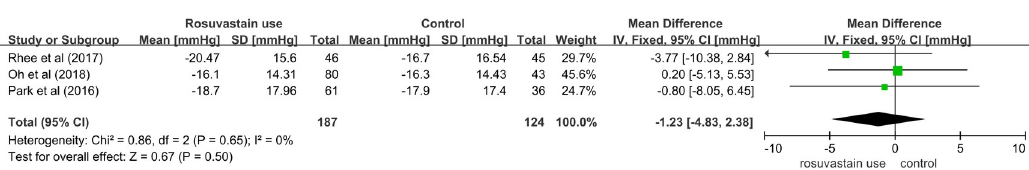
Fig 9. Pooled mean differences for the outcomes of systolic blood pressure changes in patients with hypertension treated with a triple combination of rosuvastatin plus two antihypertensive agents.